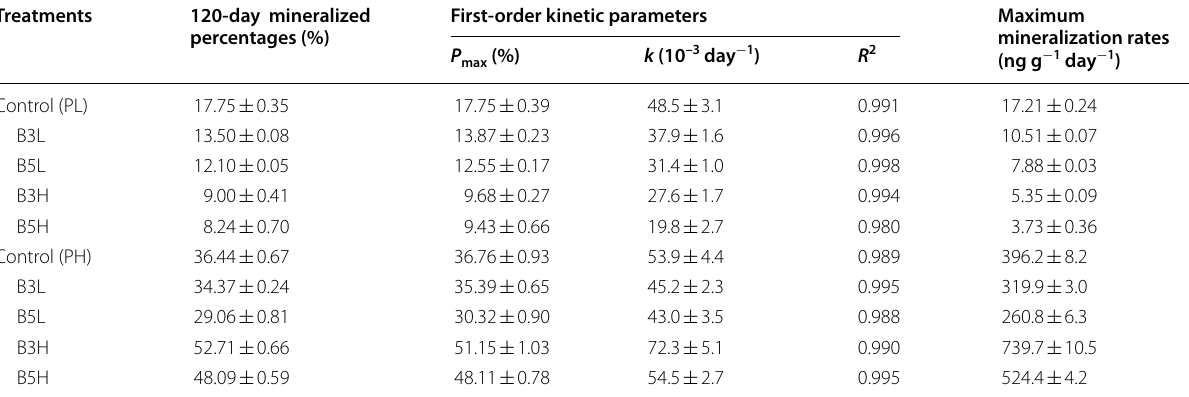
Control (PL) and Control (PH): soil spiked with low and high concentrations of phenanthrene alone, respectively; BnL and BnH: phenanthrene-spiked soil amended with low and high doses of biochar, respectively; “n” indicates charring temperatures of 300 and 500